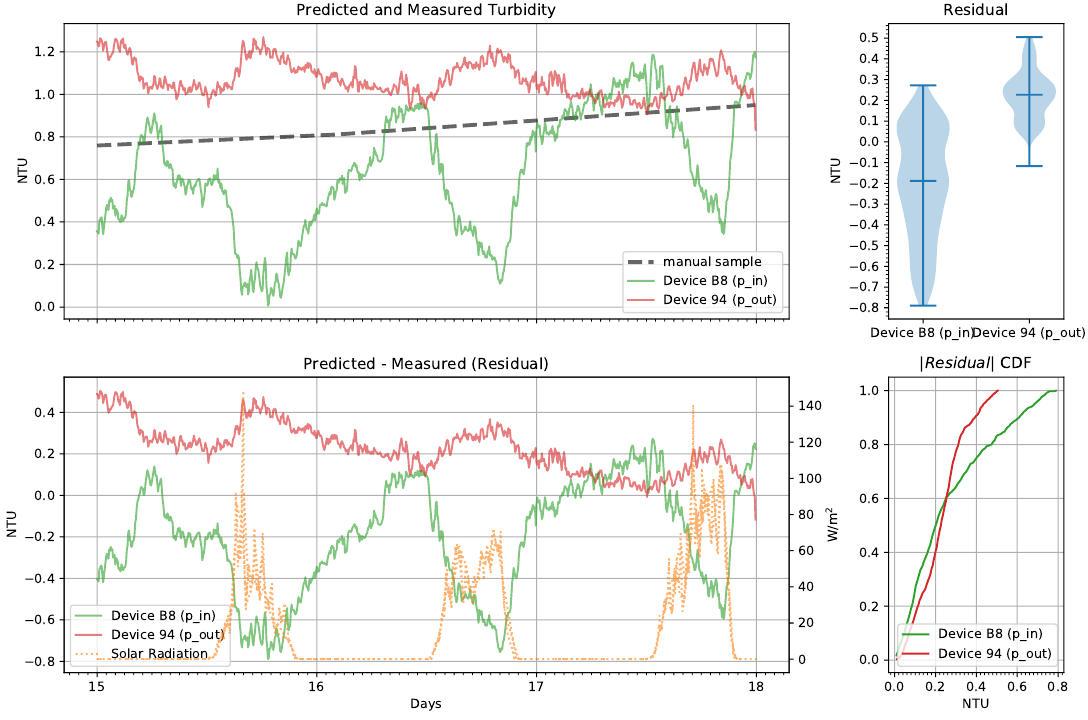
Figure 15. Pumped tank low-cost continuous turbidity monitor predictions from the pump inlet (p_in) and outlet (p_out) and manual measurements from a hand-held turbidimeter showing days 15 through